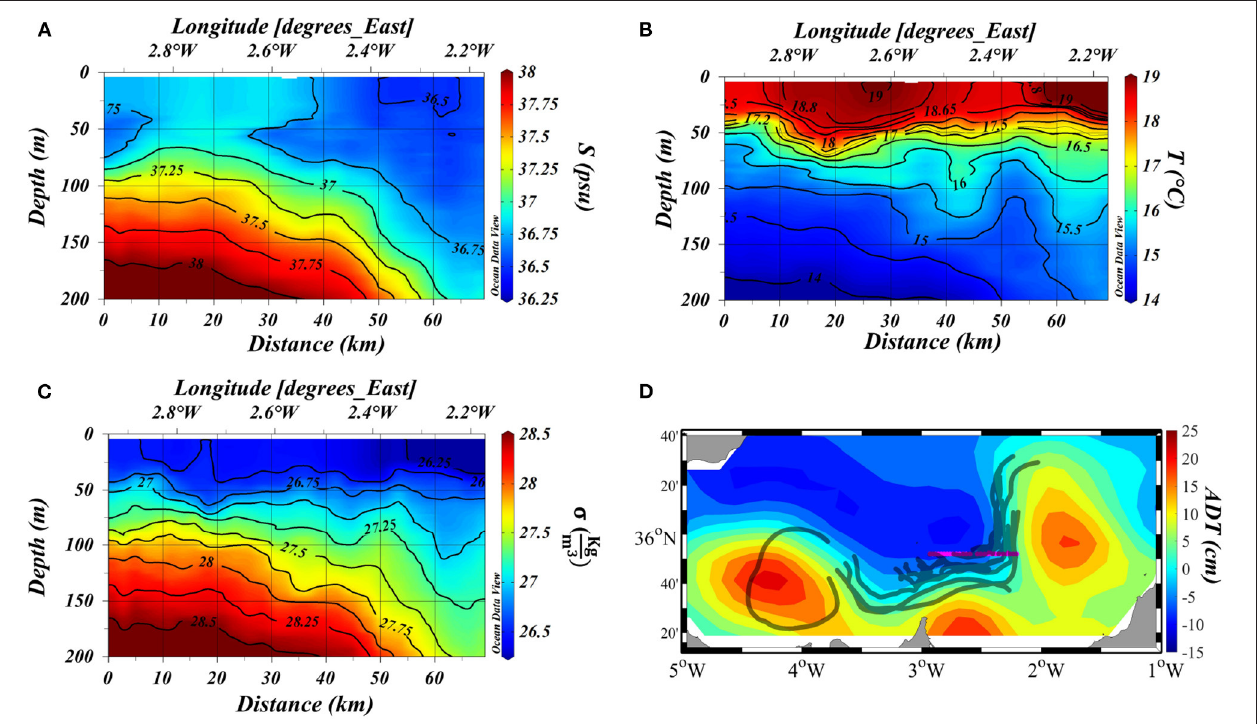
FIGURE 3 | UCTD transect (28–31 May) of salinity (A) , temperature (B) , and potential density (C) from the CALYPSO experiment 2018. Panel (D) shows the 4-day mean ADT, together with the position of the transect (in magenta, also shown in Figure 1 ), and drifter trajectories (CODE, CARTHE, and SVP) during the transect time